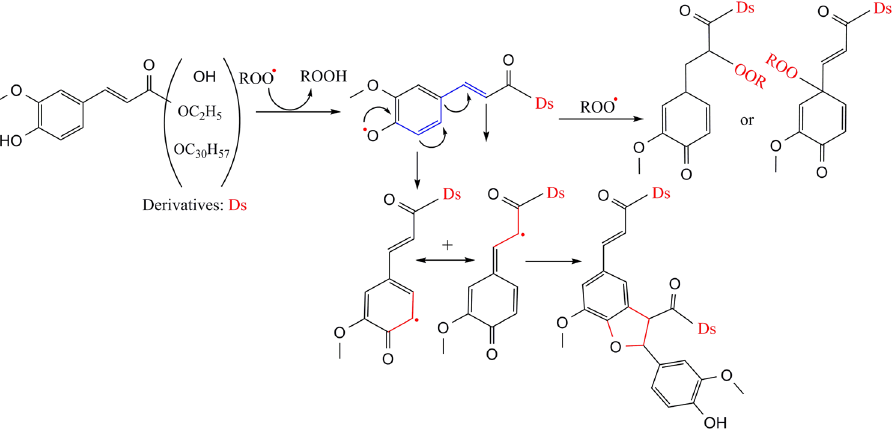
Figure 4. A proposed inhibitory mechanism of ferulic acid and its derivatives, as well as electron resonance delocalization during the oxidation process (as represented by the blue color), and the collision between two antioxidant radicals or peroxyl radical (ROO • ) and antioxidant